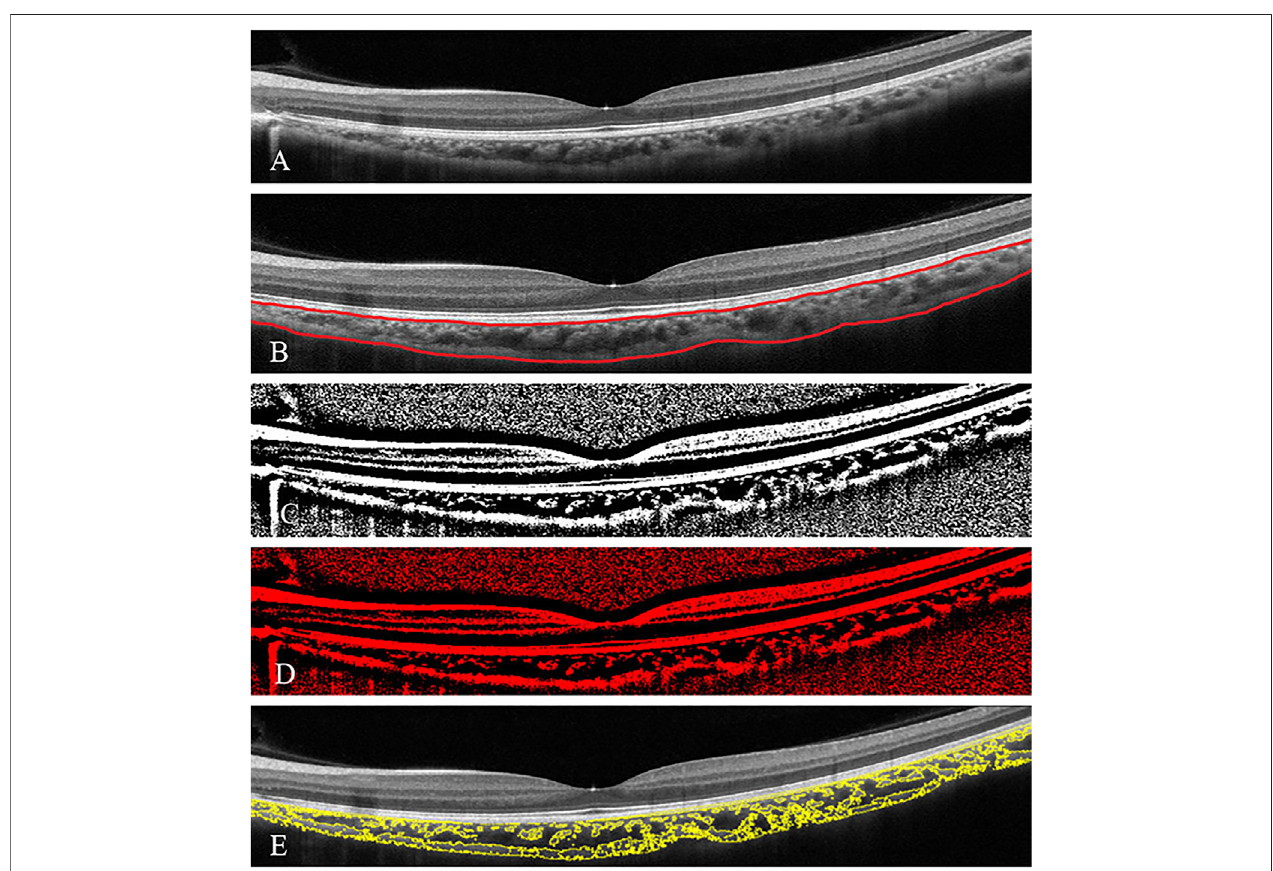
FIGURE 1 | Subfoveal choroidal thickness and choroidal vascularity index (CVI) analysis in a patient with glaucoma (A) . The enhanced-depth imaging optical coherencetomography(EDI-OCT) imageofoneeyeofpatientwithglaucoma (B) Choroidalboundarieswereautomaticallyidenti fi edandassessed bythetwooperators (red lines) (C) The total choroidal area (TCA) was determined by the binarised EDI-OCT image (D,E) CVI was derived as a proportion of the choroidal vasculature (yellow outlines) against the TCA by image binarisation.